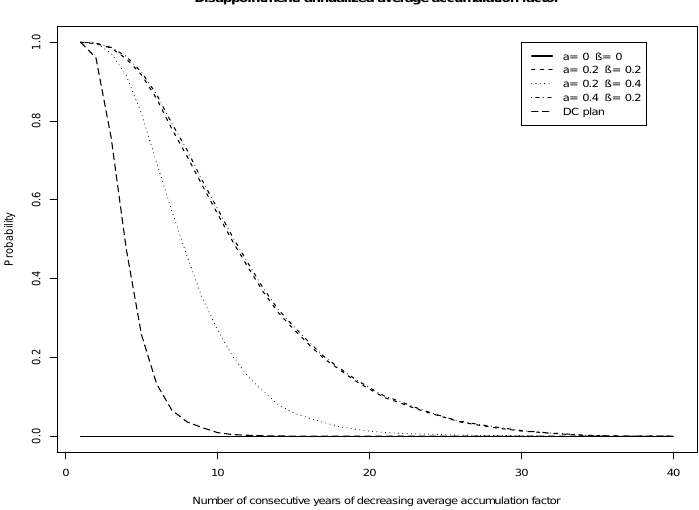
Figure 7. Disappointment for the more realistic membership when the target funding level ¯ F = 100%. The probability of a declining average AAF plotted against the number of consecutive years that the decline occurs over. Both the investment risk adjustment ( a ) and the AAF adjustment ( b ) are varied.